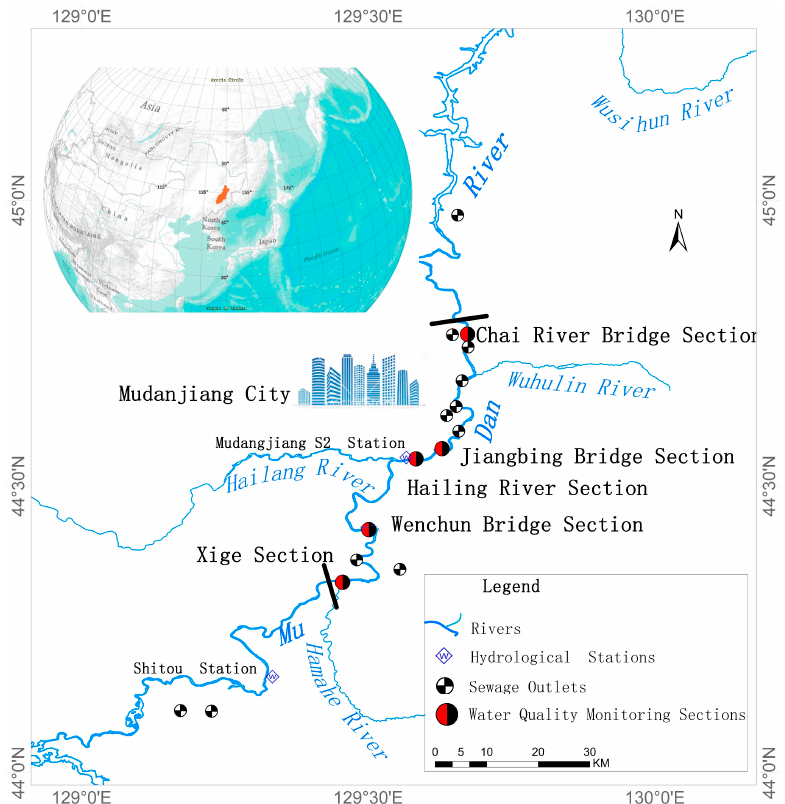
Figure 1. Schematic diagram for rivers, sewage outlets and monitoring sections in the research